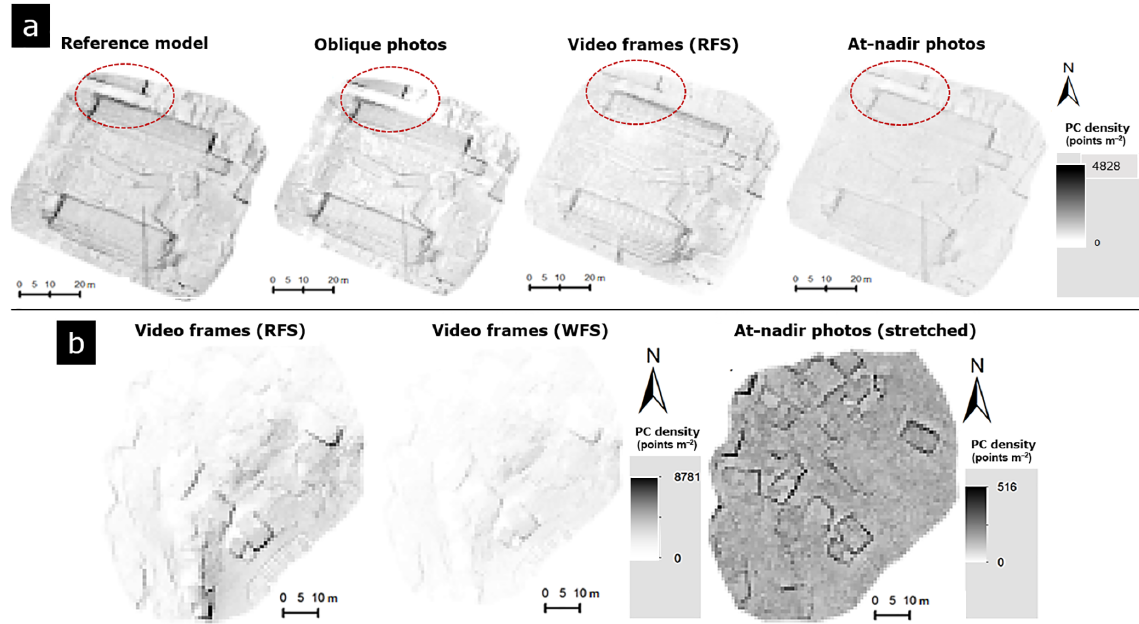
Figure 7. Vertical point cloud density raster maps generated for the completeness analysis. 3-D point clouds of (a) Tainan and (b) Pescara del Tronto. Dashed red circle: noticeable difference in completeness between 3DPCs of Tainan. Table 4. Computed mean point cloud densities (points per cell or m 2 ) and proportion of empty cells (%) from horizontal and vertically projected point cloud density raster maps. Bold numbers are relevant values, in every study case and perspective. Study